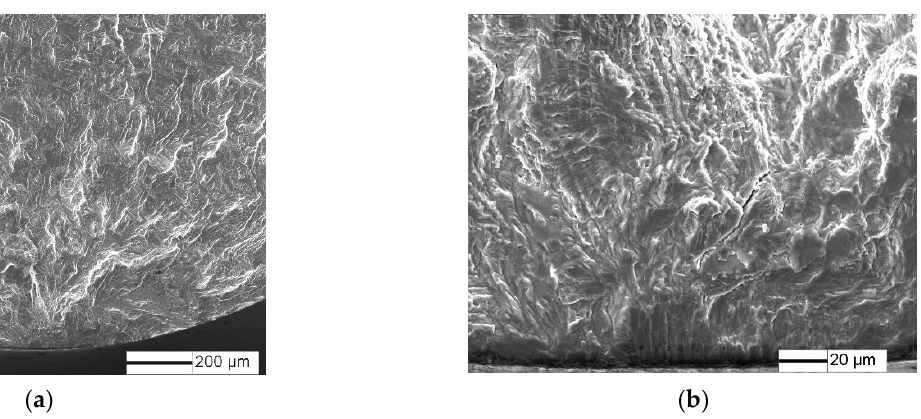
Figure 4. Fracture surface for 2.5% predamage specimens at σ = 500 MPa and N = 3.4 × 10 5 cycles: ( a ) macroscopic morphology, and ( b ) crack initiation morphology.